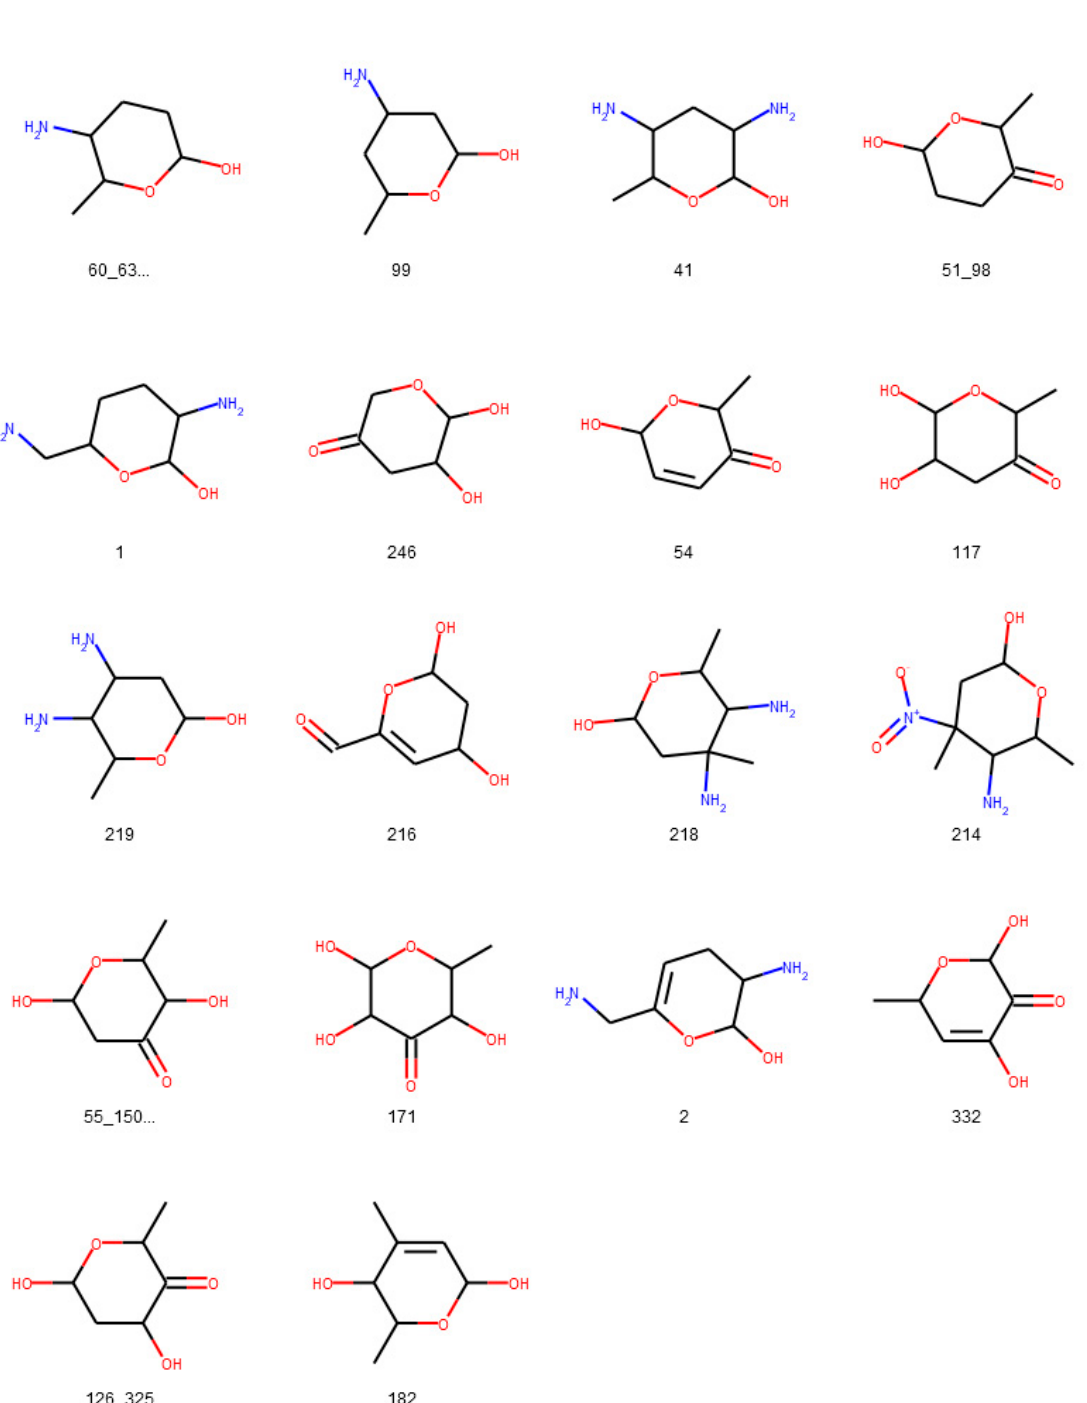
Figure 16. Glycosidic moieties reported in bacterial NPs detected at least ten times in COCONUT that cannot be detected by the SRU after lowering the exocyclic oxygen ratio threshold setting to 0.3. All moieties are arranged for decreasing frequency in COCONUT, corresponding to the orange bars in Figure 15. The ID below the structures refers to the identifiers used in the original publication of the dataset, concatenated where stereoisomers were grouped.